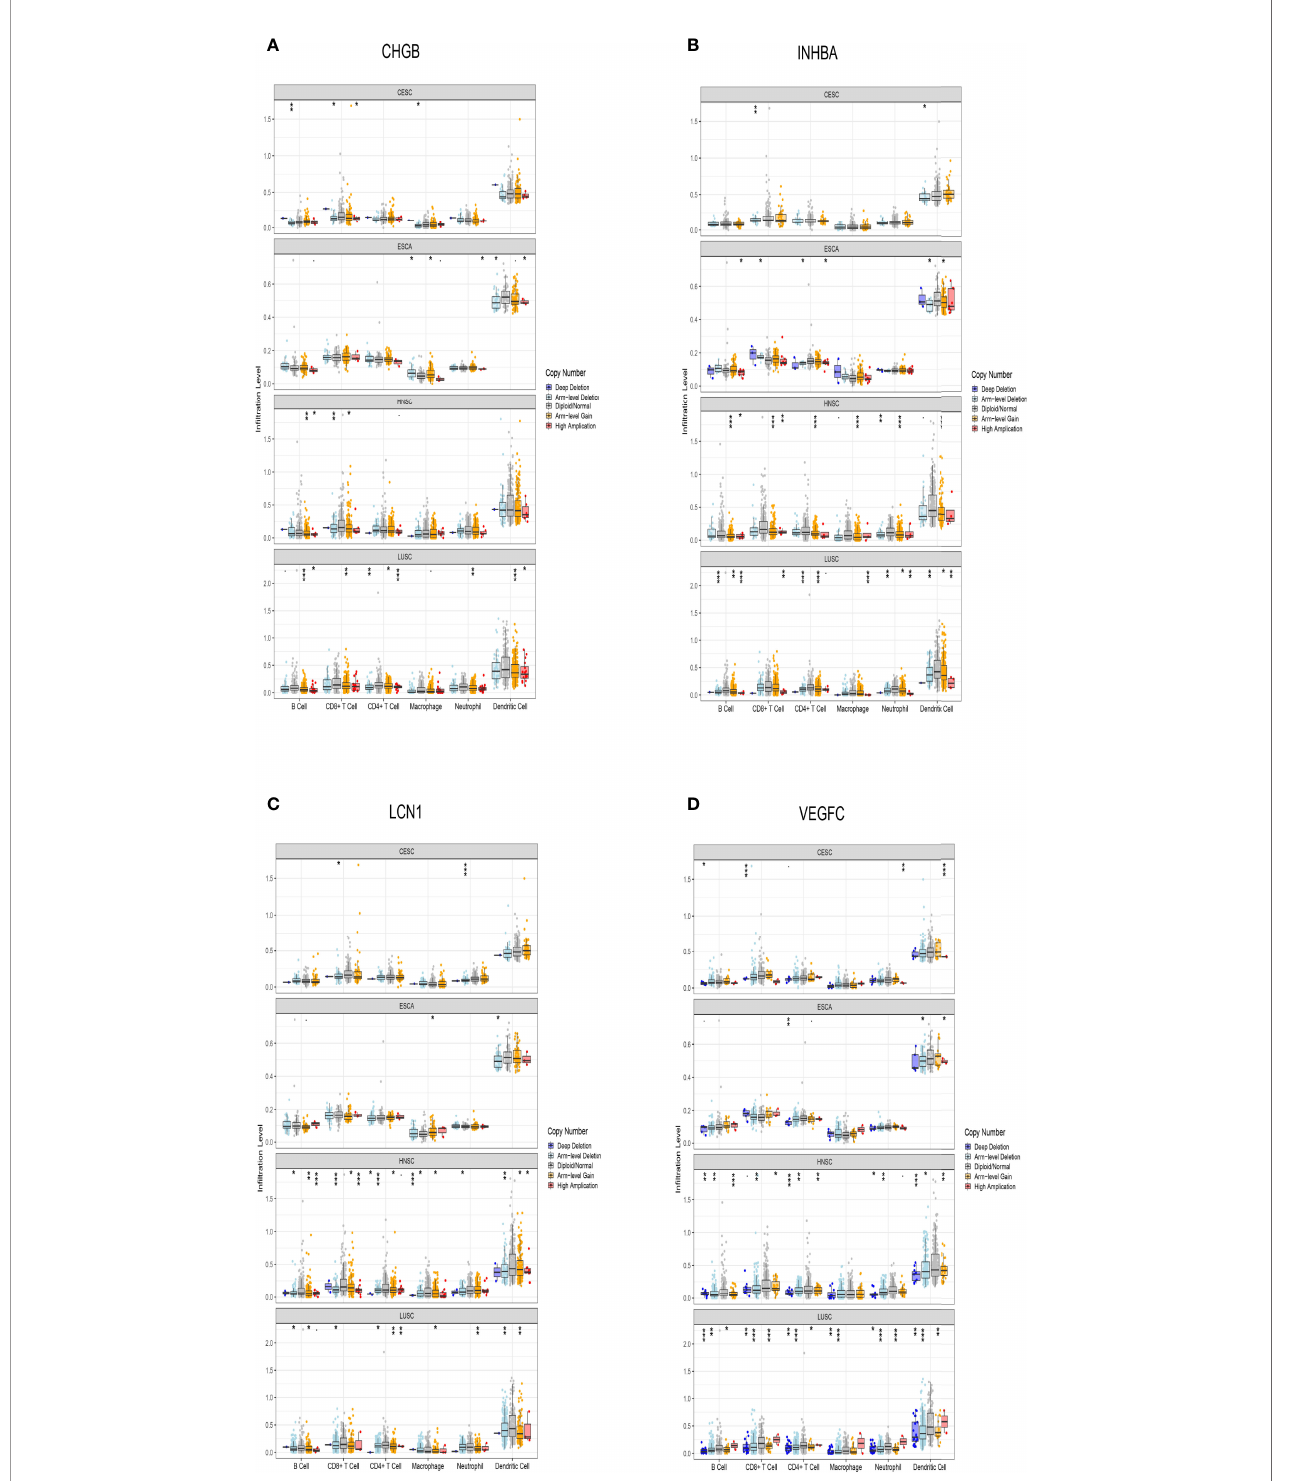
FIGURE 6 | Association between somatic copy number alteration (CNA) of prognosis-related hub genes and immune cell in fi ltration levels. (A – D) CNA of hub genes could reduce immune cell in fi ltration. * means p< 0.05, ** p< 0.01, *** p<